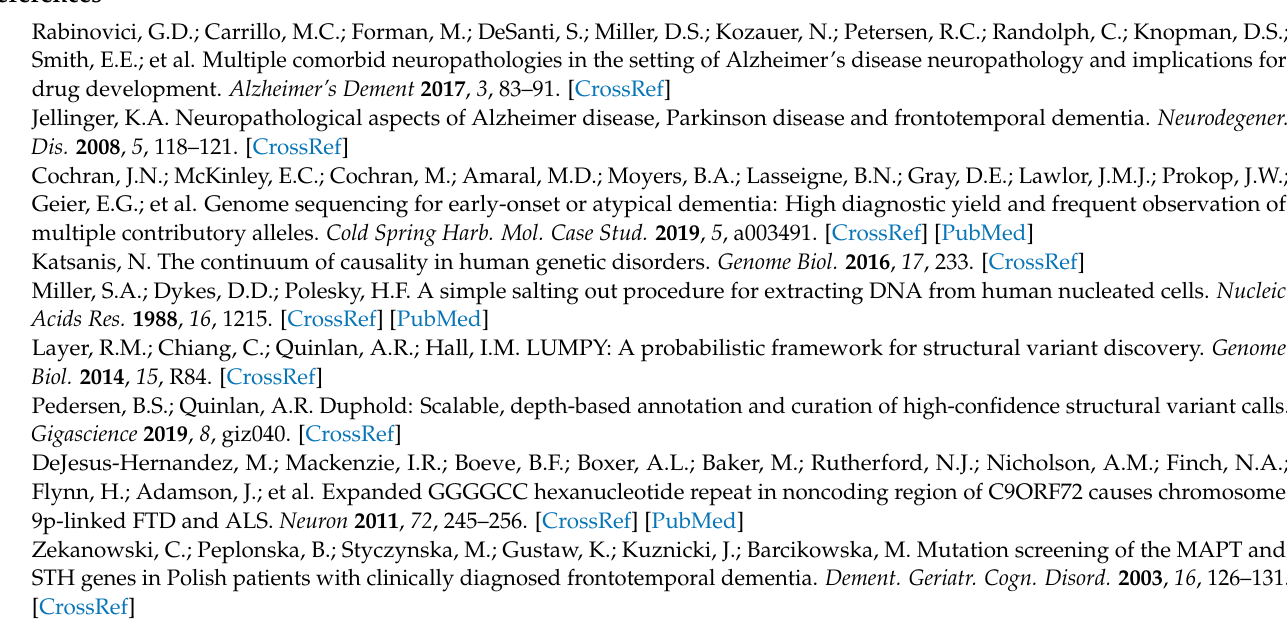
panel; Table S2: List of genes selected for variant analysis; Table S3: Control fibroblast lines used for the study; Table S4: Primers used for the study; Table S5: Neuropsychological assessment of the proband’s brother; Table S6: Addenbrooke’s Cognitive Examination-III of the proband; Table S7: Detailed neuropsychological assessment of the proband; Table S8: Variants identified in the proband according to selected criteria; Table S9: Human Splicing Finder Analysis of BACE1 variant; Figure